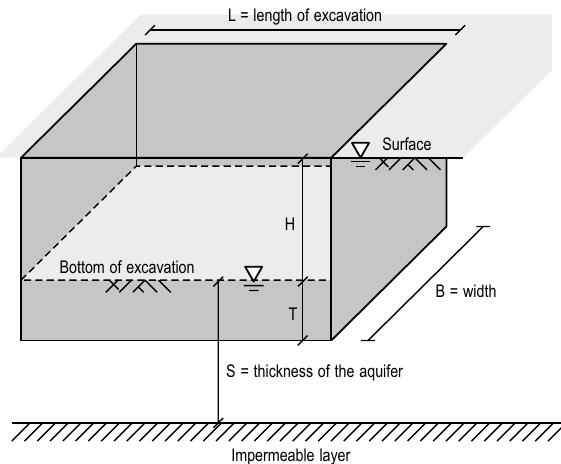
Fig. 4. System sketch for three-dimensional